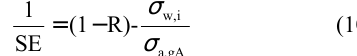
Fig. 2 a sketch of the inner of the IUN RC with a particular of the enclosure employed in the measurements, is